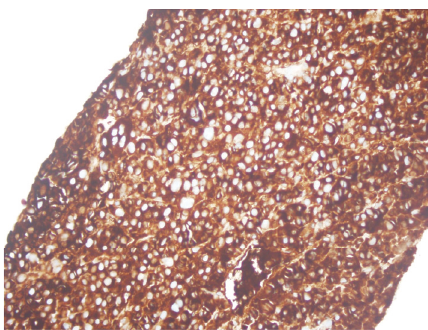
Figure 7: Liver biopsy stained for lambda light chain immunoglob- ulin confirming neoplastic extramedullary plasma cell infiltration from multiple